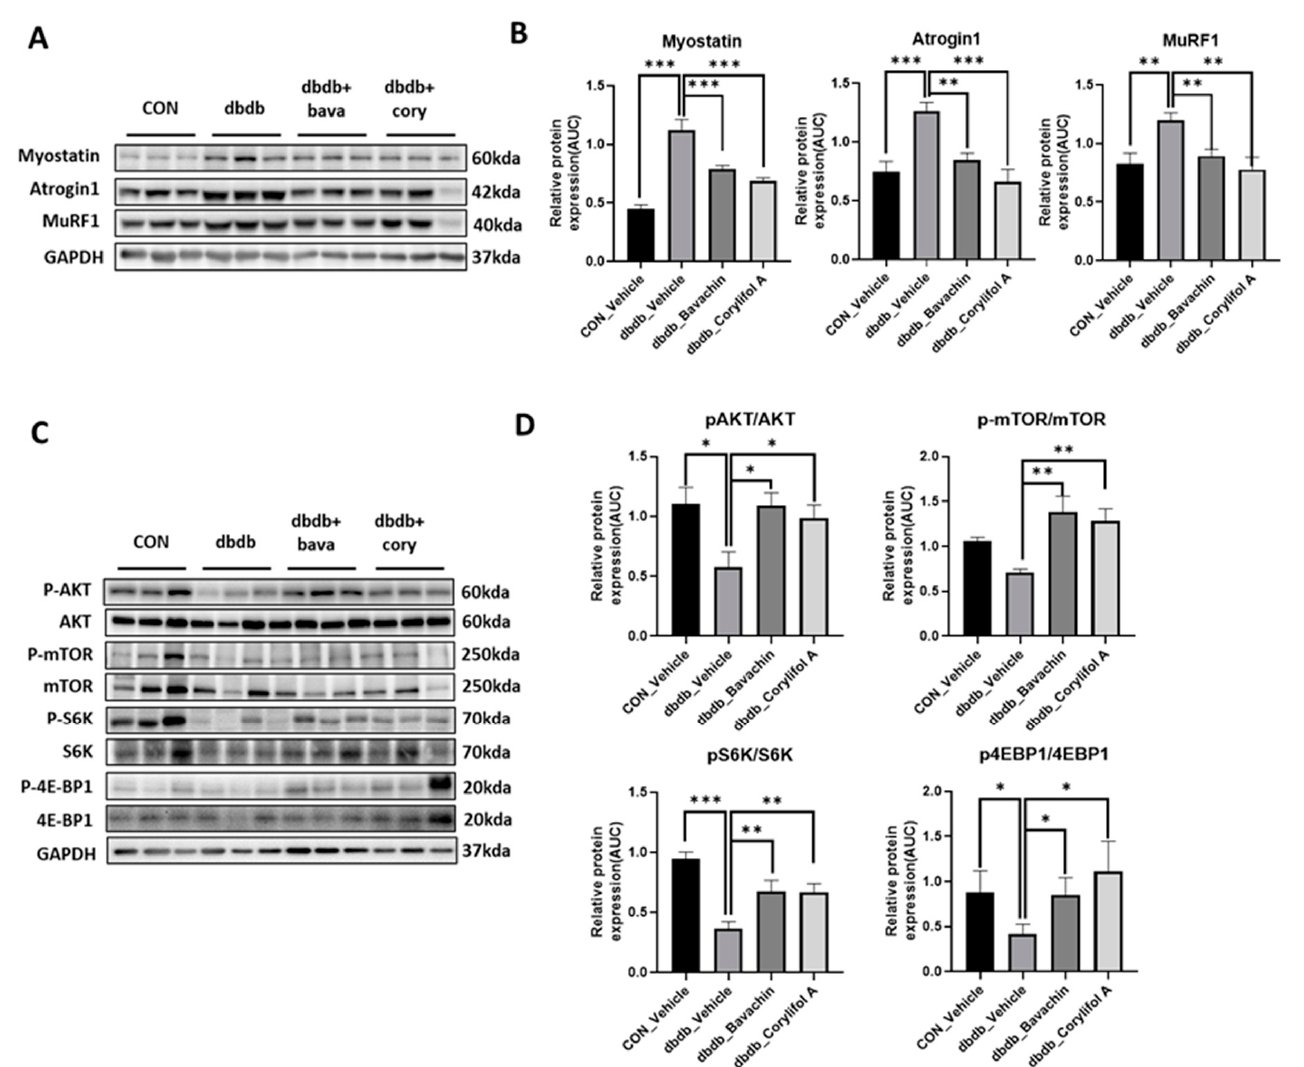
Figure 4. Bavachin and corylifol A decrease muscle atrophy in db/db mice. Twelve week old male db/db mice were administered bavachin (10 mg/kg) or corylifol A (10 mg/kg) for 40 d. Protein expression levels in GA muscles were measured using western blotting. ( A ) Representative images of the atrophic muscle factors. ( B ) Protein expression levels of the atrophic muscle factors. ( C ) Representative images of the AKT signaling pathway. ( D ) Protein expression levels in the AKT signaling pathway. All data are represented as the mean ± S.E.M., n = 6/group; * p < 0.05, ** p < 0.01, *** p < 0.001; nonparametric analysis of variance, followed by Kruskal-Wallis test.